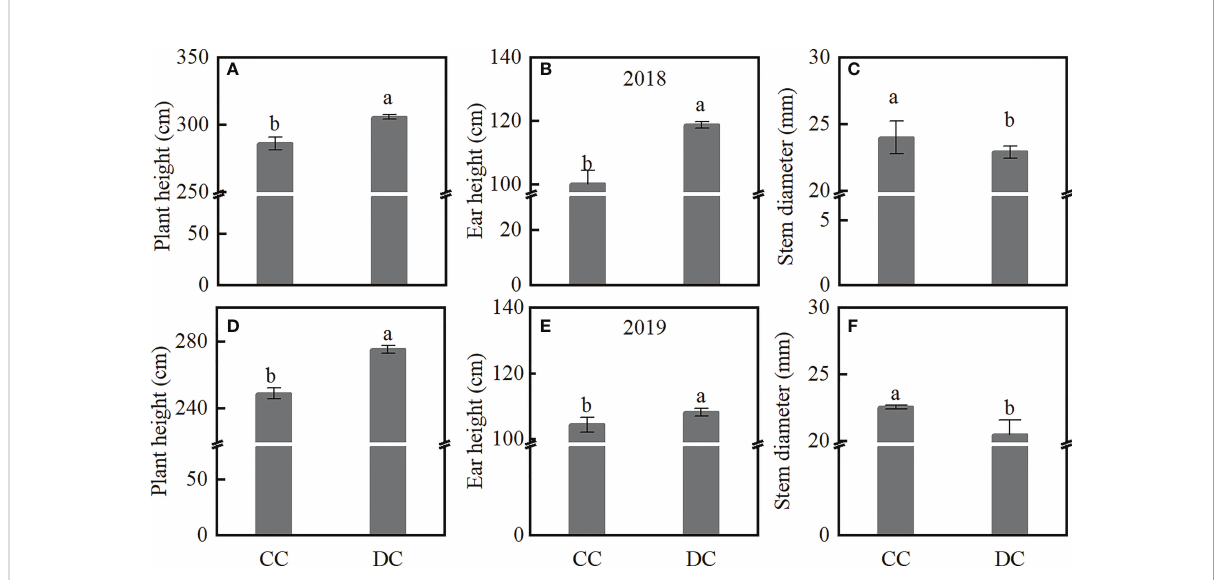
FIGURE 4 The morphology of the maize plants at the R1 stage. (A – C) : plant height, ear height, and stem diameter of CC and DC in 2018. (D – F) : plant height, ear height, and stem diameter of CC and DC in 2019. DC, Dense cultivation. CC, Common cultivation. Different letters denote signi fi cant differences ( P < 0.05), error bars show standard error of mean.